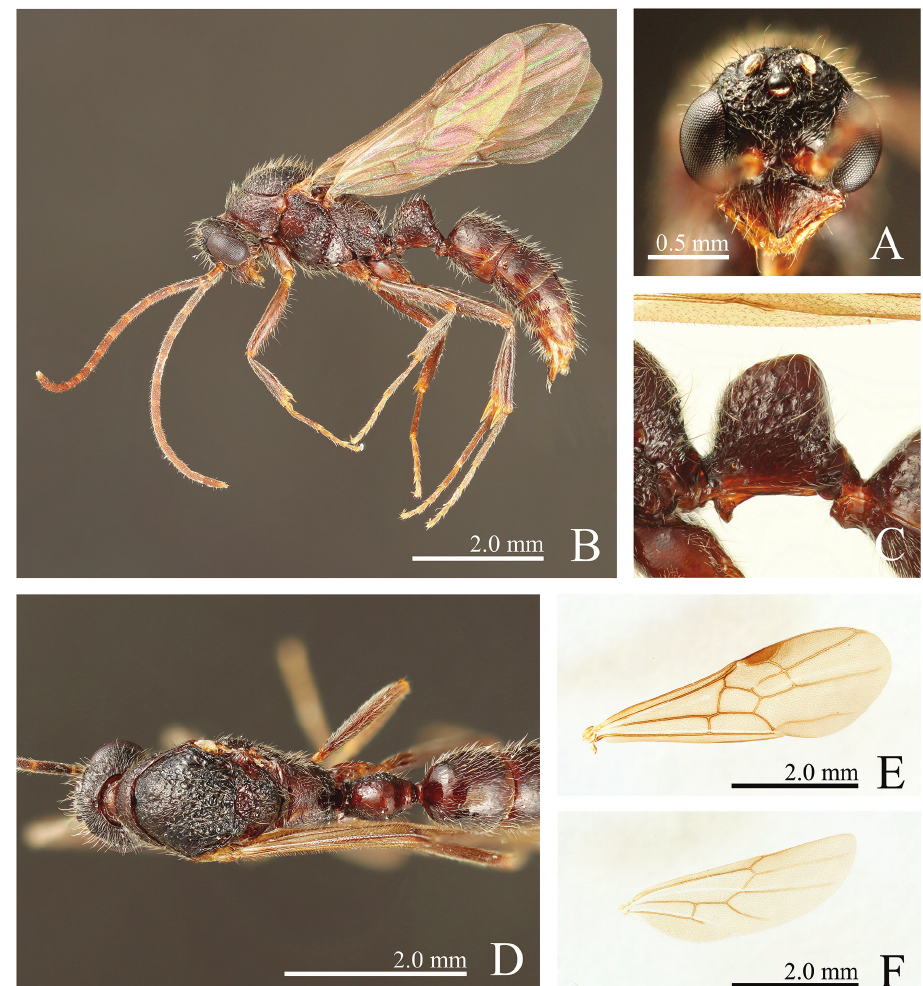
Figure 10. Leptogenys itoi sp. n., paratype, male. A head, full-face view B lateral view C petiole, lateral view D dorsal view E forewing F